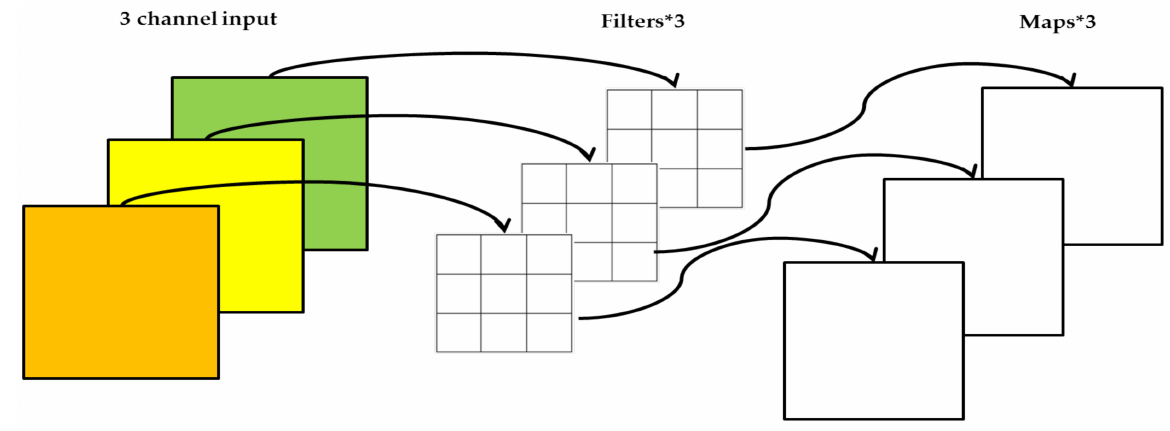
Figure 4. Depthwise convolution.